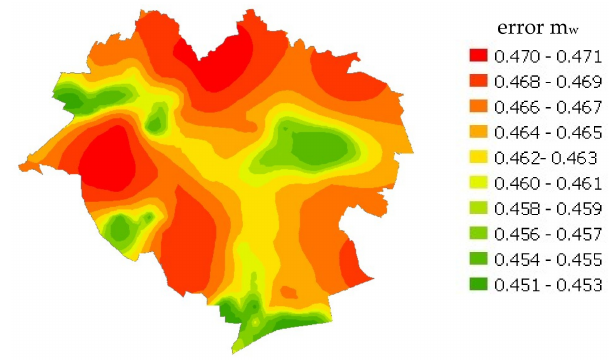
Figure 7. Estimation error m w map.